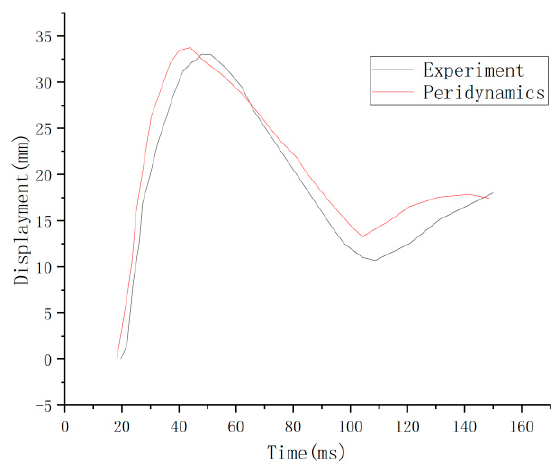
Figure 14. Midpoint displacement of the wall [14].